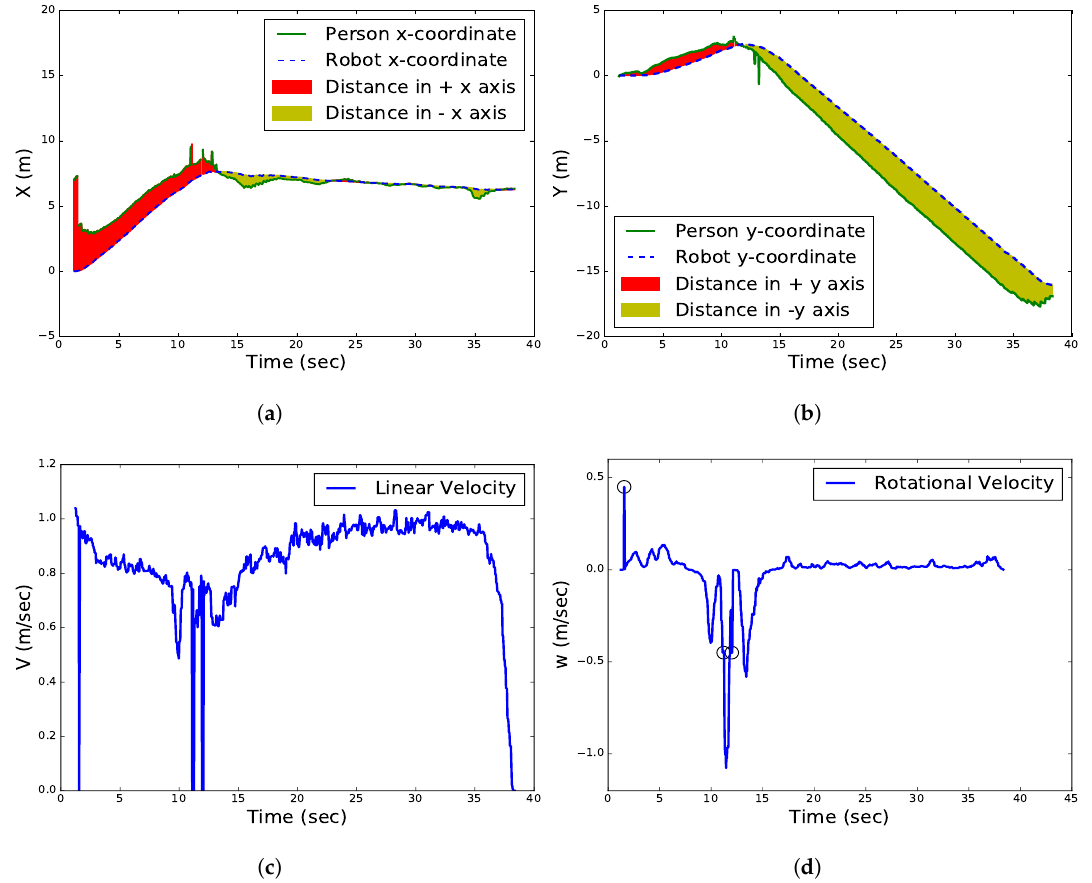
Figure 9. Robot and person movement trajectories in a realistic scenario for tracking state. ( a ) Relative position between the target and the robot in the x-coordinate. ( b ) Relative position between the target and the robot in the y-coordinate. ( c ) Linear velocity. ( d ) Rotational